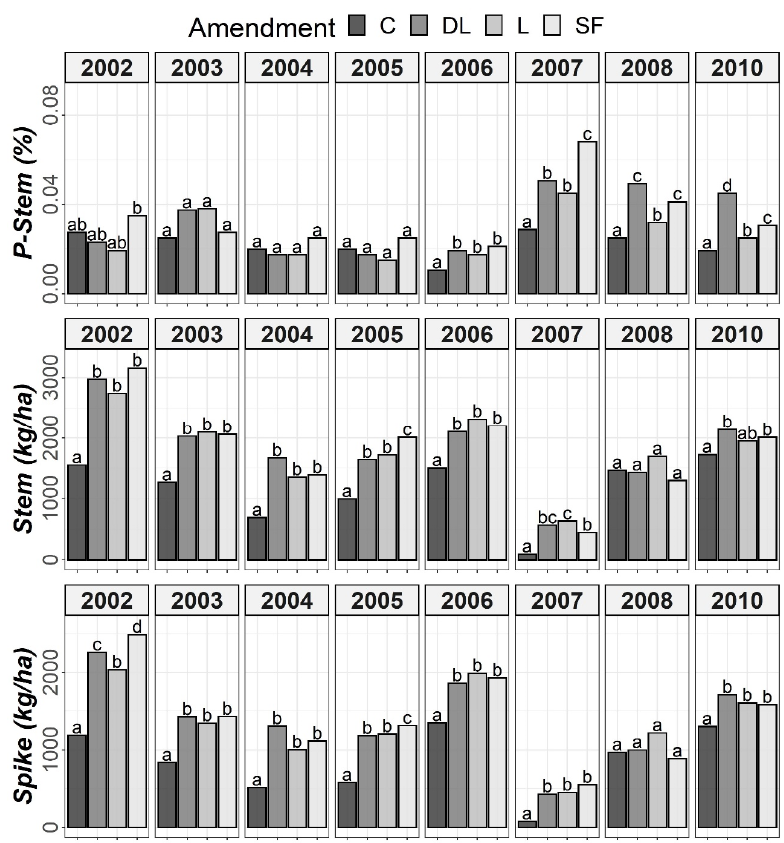
Figure 7. Temporal evolution of phosphorus levels in stems (P-Stem) and both Stem and Spike biomass throughout the research period (2002–2010). Bars within each year followed by different lowercase letters reflect significantly different averages according to Tukey’s honest significance test with Holm–Bonferroni adjustment ( p = 0.05).